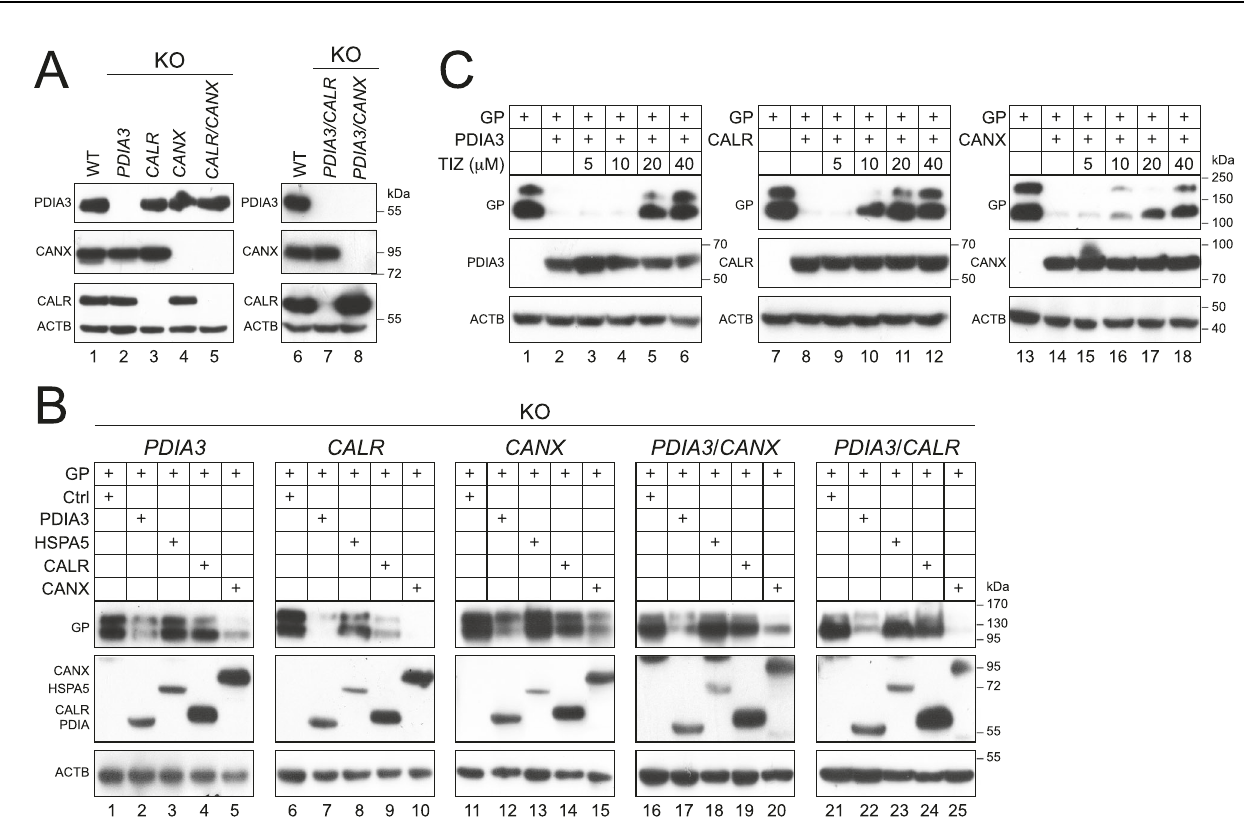
Fig. 2 | CANX and CALR reduce EBOV entry. A HIV-1 fi re fl y luciferase reporter viruses pseudotyped with EBOV-GP 1,2 were produced from HEK293T WT, PDIA3, CALRorCANX-overexpressing,and PDIA3 -, CALR -or CANX -KOcells.Afterinfecting HEK293T cells with an equal number of these different viruses, viral entry was determined by measuring intracellular luciferase activities. Viral entry is shown as relative values, with the entry of viruses produced from HEK293T WT cells in the presence of a control vector set to 100%. B EBOV replication and transcription-